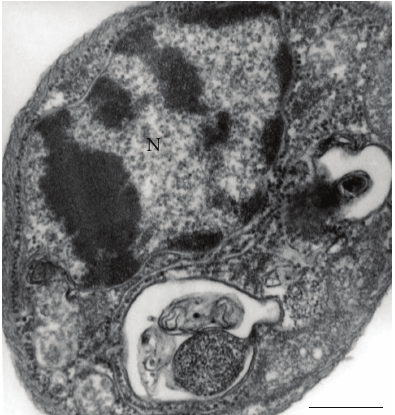
Figure 14: Leishmania amazonensis promastigote treated with sterol biosynthesis inhibitors showing a condensation of the nuclear chromatin, a characteristic feature of the apoptosis-like cell death process. N, nucleus. Bar, 0 . 5 μ